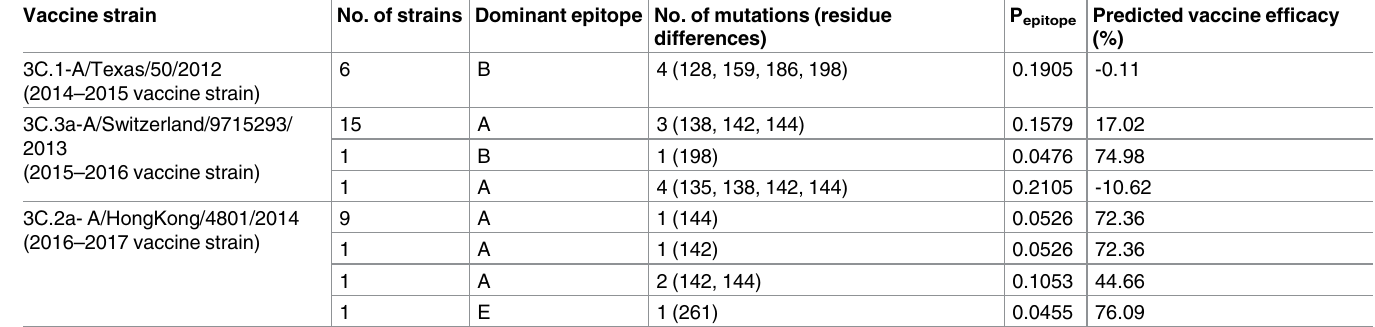
Table 2. Efficacy among the vaccine strains and number of mutations found on the dominant epitopes of influenza A(H3N2)circulating in Cameroon. Vaccine strain No. of strains Dominant epitope No. of mutations (residue